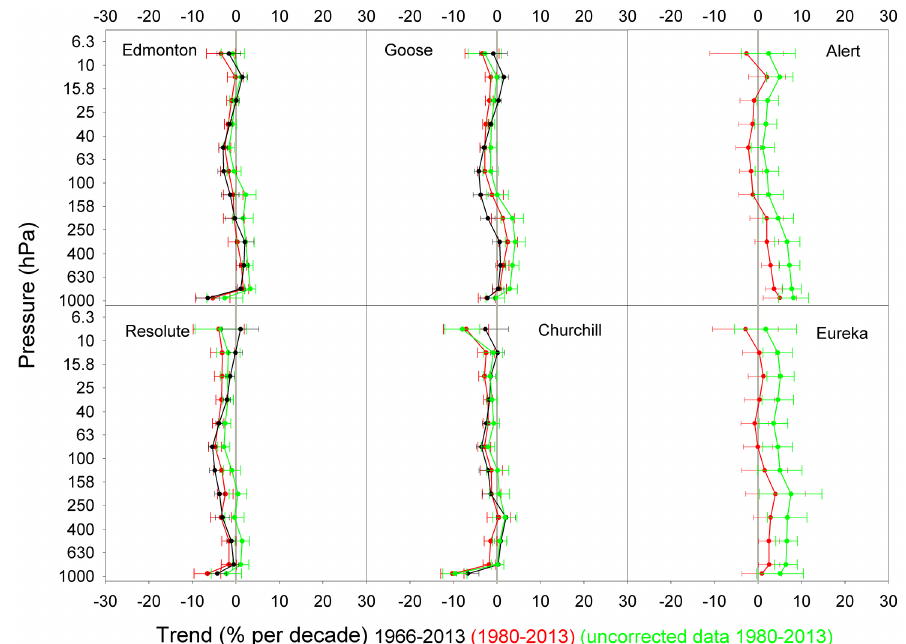
Figure 15. Linear trends in ozone mixing ratio for the overall (48-year) period at the six Canadian sites with long-term ozonesonde records, for the surface and 11 layers equally spaced in log pressure ( ∼ 3km). Error bars show 95% (2 σ) confidence limits. The troposphere and stratosphere have been explicitly separated; that is, integration of the 250–158hPa layer starts either at 250hPa or at the tropopause, when the latter is found above 250hPa. Similarly, integration of the 250–158hPa layer starts either at 250hPa or at the tropopause, when the latter is found above 250hPa. Trends using only ECC data (from 1980) are shown in red. Trends from 1980 using ECC data before corrections are applied are shown in green.